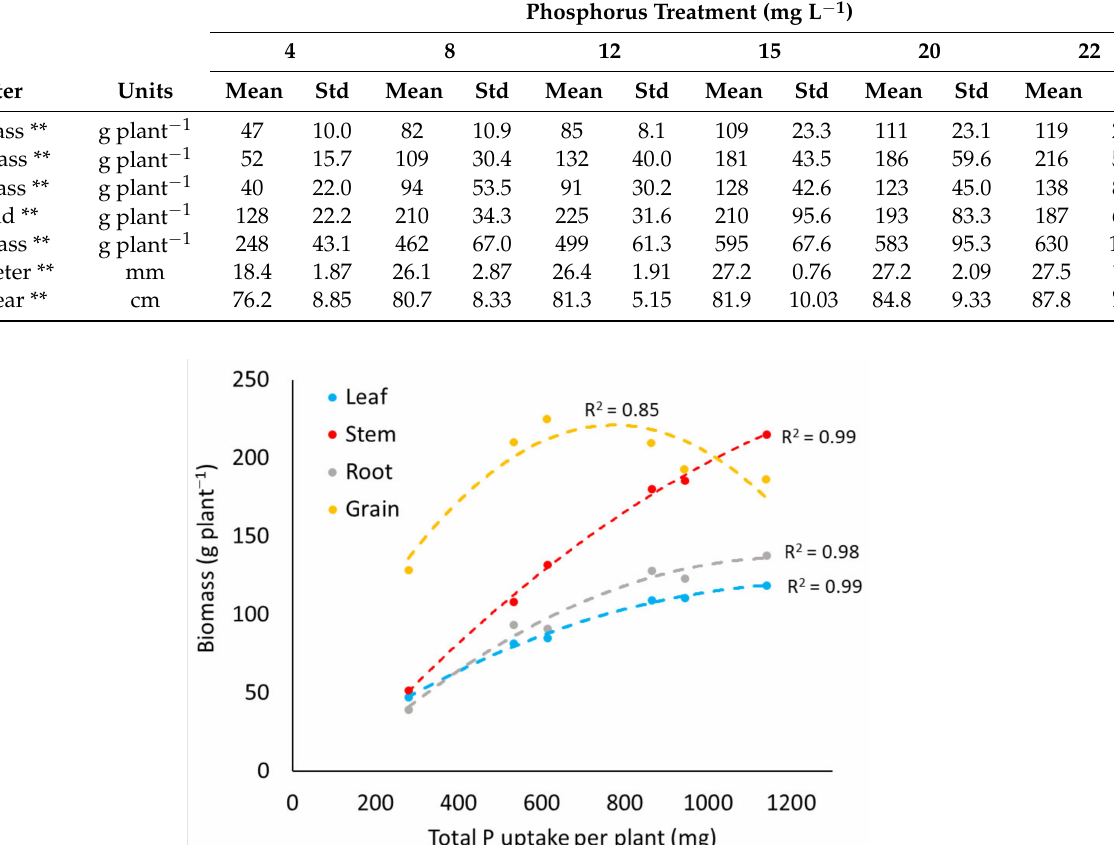
Table 1. Plant part mean and standard deviation (Std) for phosphorus (P) concentration treatments (4 to 22 mg P L − 1 ) averaged across three hybrids and four replications. “Stem biomass” includes stem, cob, and tassel, and “Leaf biomass” includes leaves and husk. ** indicates a significant P treatment effect at p -level of 0.01. All mass presented on dry weight basis except for grain (reported at 15.5% moisture).